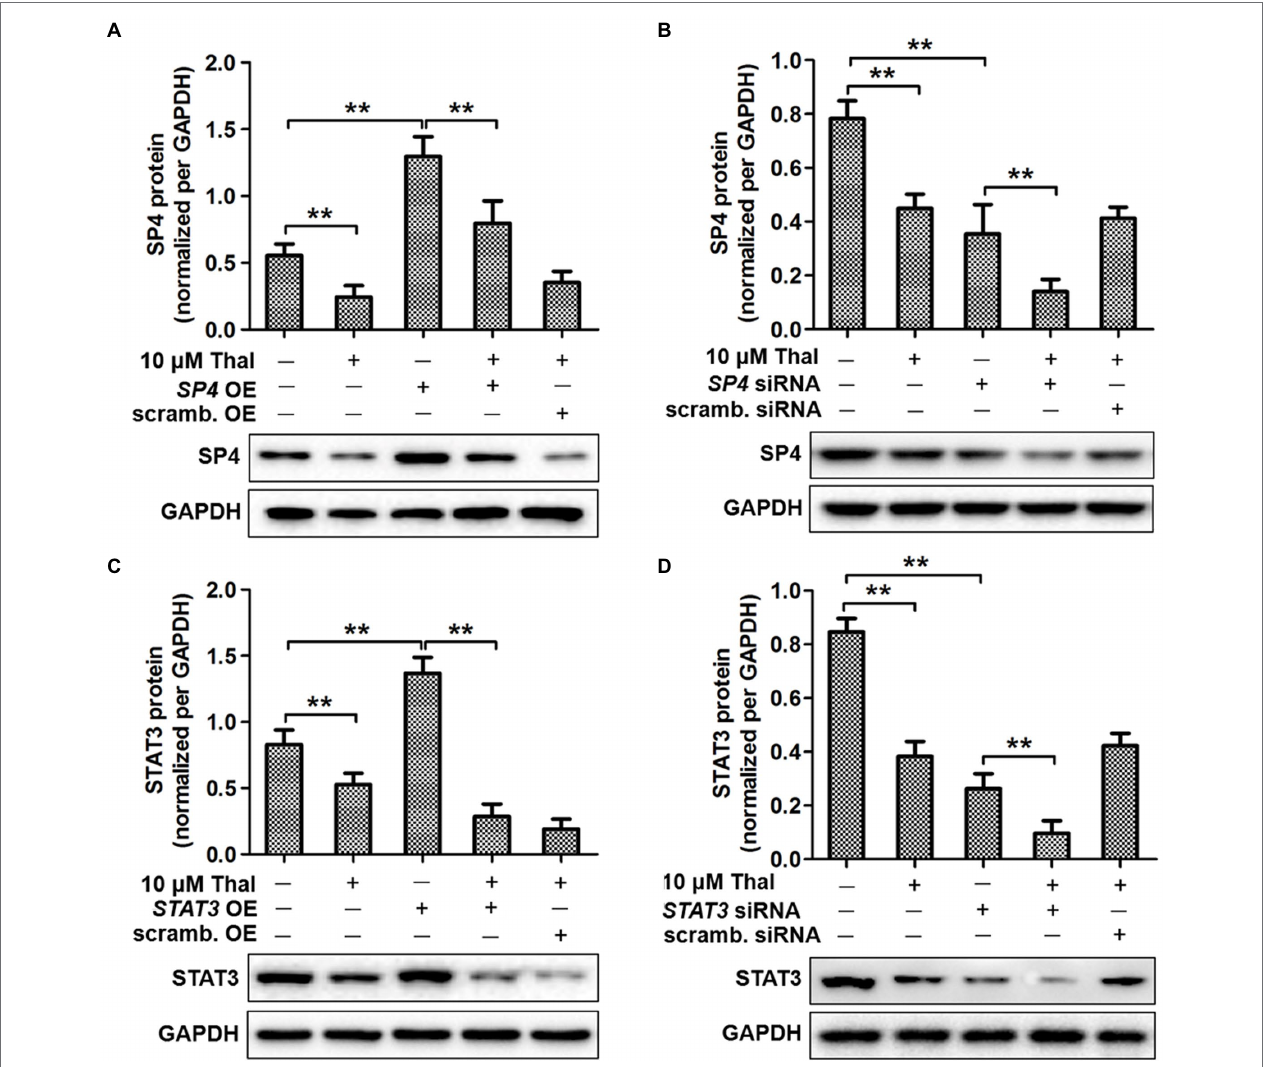
FIGURE 2 | The role of STAT3 and SP4 in SP4–mediated VEGF induction by thalidomide. Effects of SP4 overexpression (A) and silencing (B) on SP4 expression. Cells were transiently transfected with either SP4 OE or scrambled (scrambled.) OE and SP4 siRNA or scrambled (scrambled.) siRNA. Then, the cells were stimulated with thalidomide (10 μ M) for 24 h. The expression of STAT3 was analyzed in cells transfected with either STAT3 OE (C) or STAT3 siRNA (D) . Cells were assessed for SP4 and STAT3 protein expression by Western blotting. Quantitative analysis of SP4 and STAT3 protein expression was normalized to GAPDH expression. * p < 0.05; ** p <